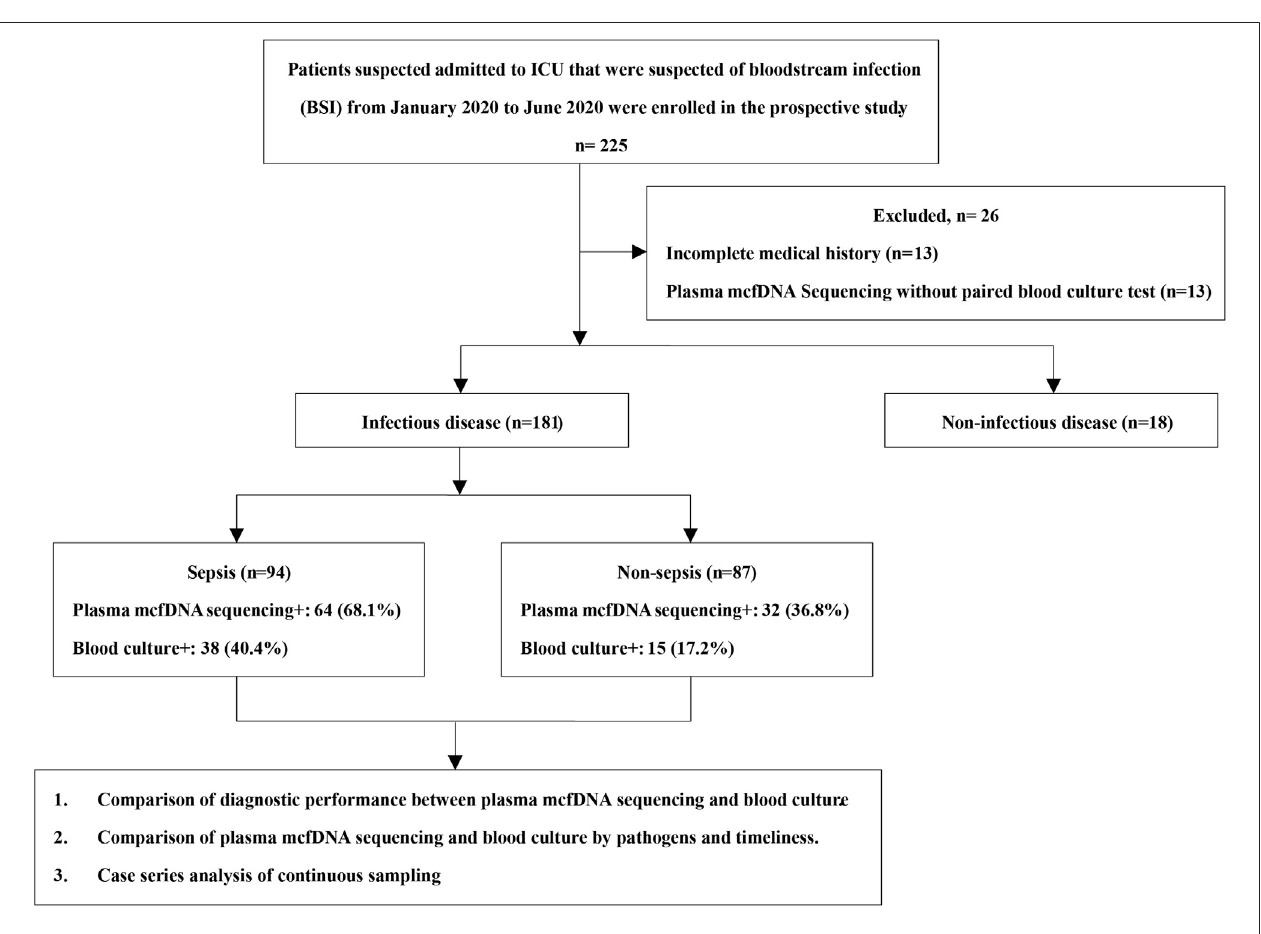
FIGURE 1 | Flowchart of the Study. ICU, intensive care